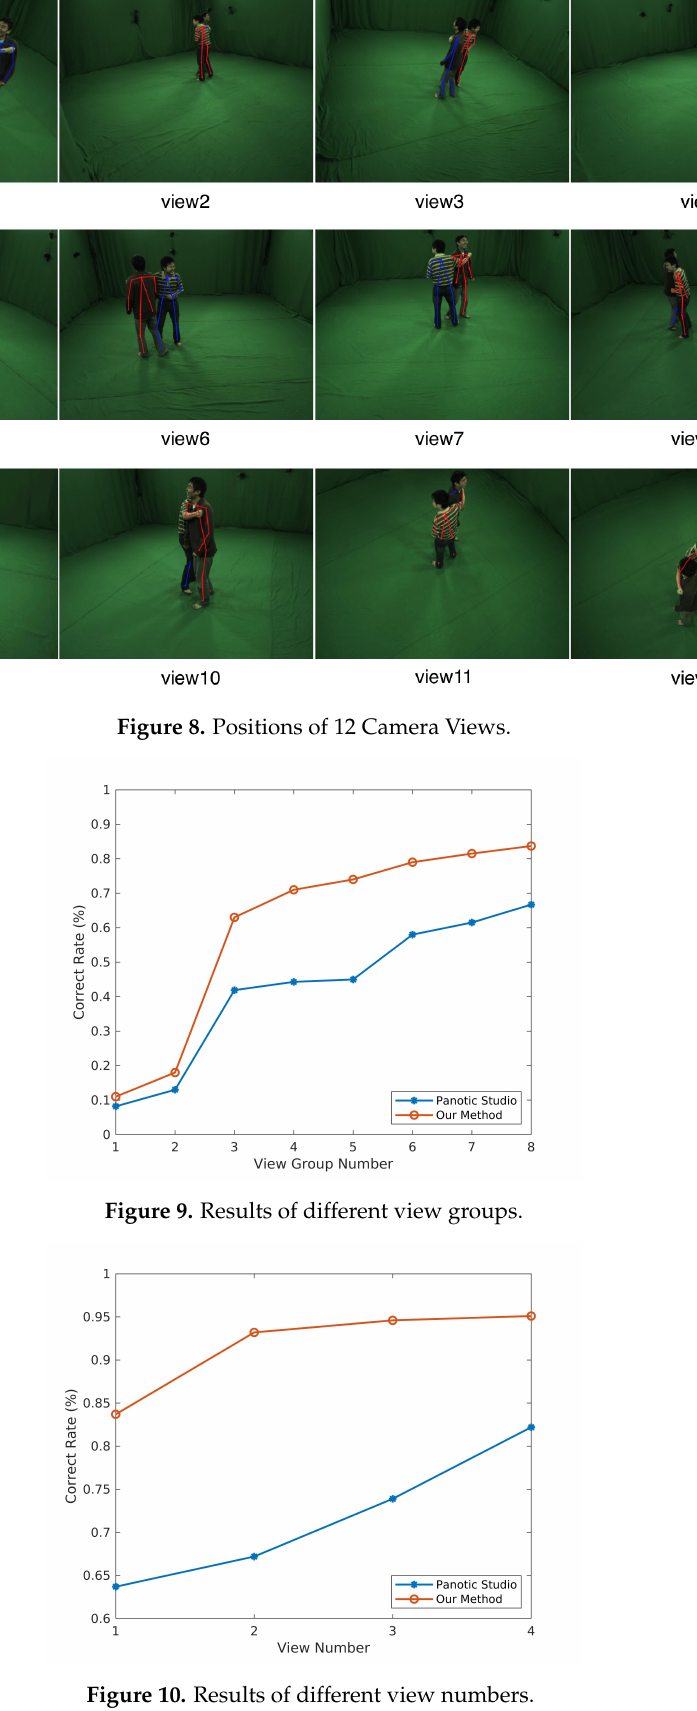
Figure 10. Results of different view